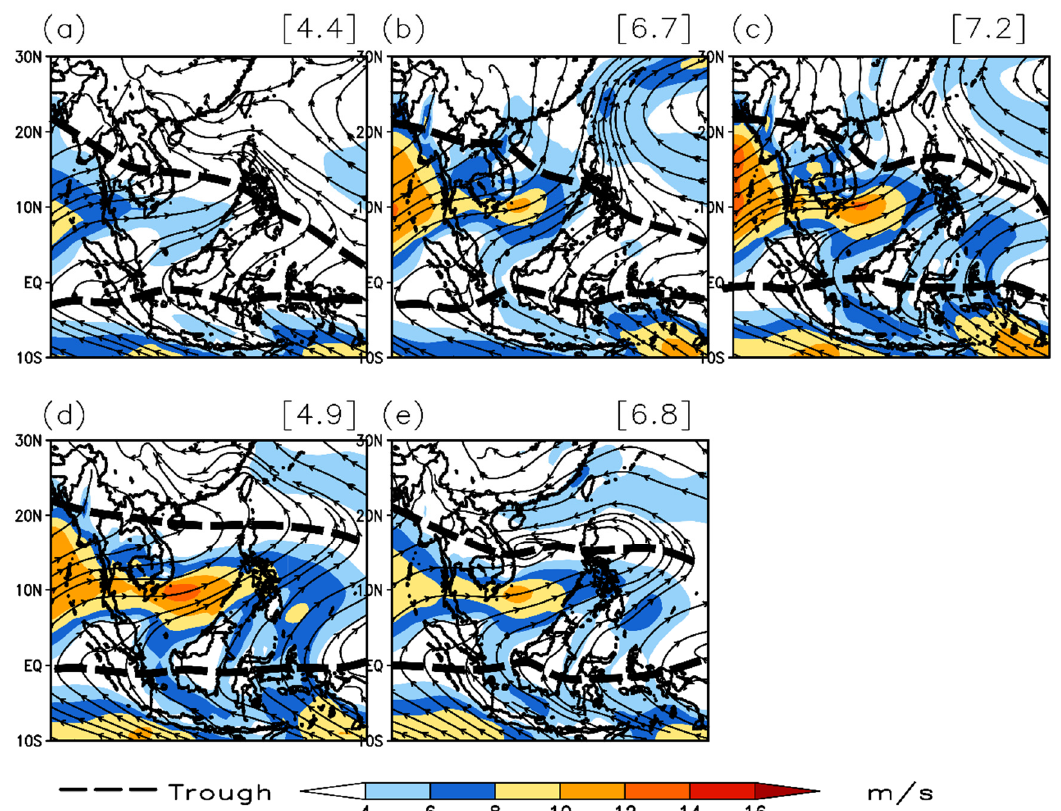
Figure 8. Composite 925-hPa daily wind streamline charts of all collected BSL days in ( a ) May, ( b ) June, ( c ) July, ( d ) August; and ( e ) September from the year 1998 to 2018. The average frequency (day) of BSL per month is indicated in the bracket at the upper corner of each panel. Blue to red shaded area indicates stronger wind speed, while monsoon trough is denoted by a black, thick-dashed line.